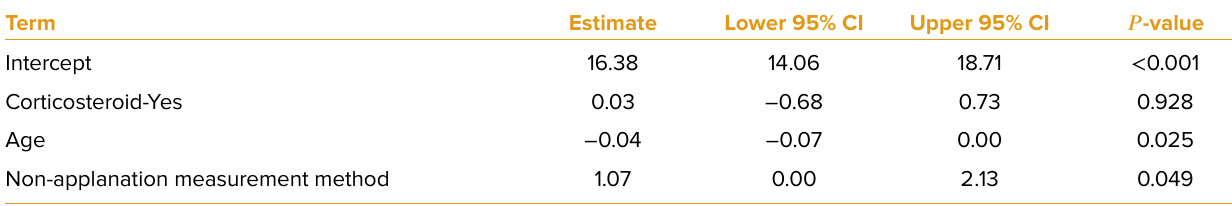
Table 5. Results of regression analysis for IOP with corticosteroid use as covariate of interest. Term